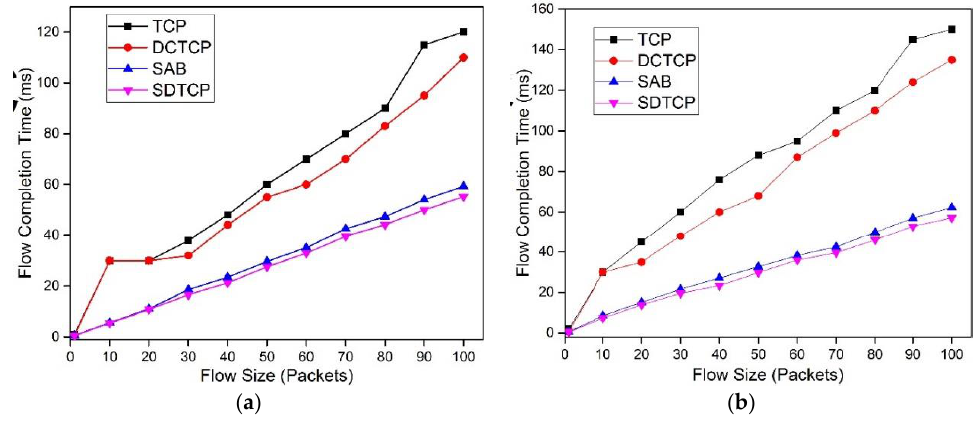
Figure 14. Mean and 99th percentile FCT for 50 burst flows: ( a ) m FCT; and ( b ) 99th percentile FCT.